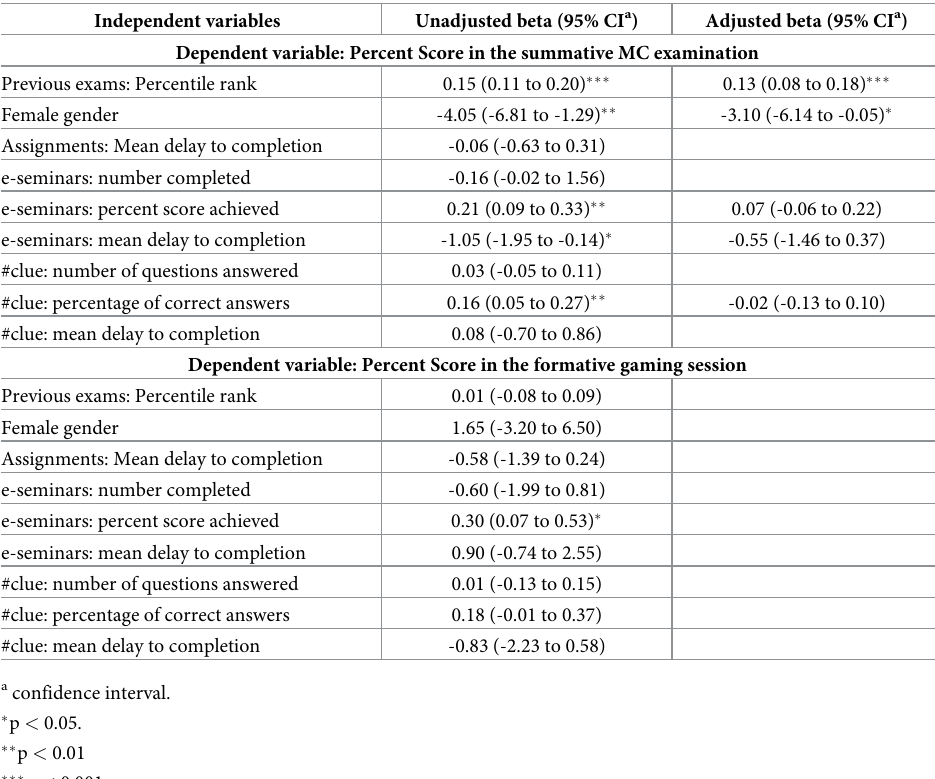
Table 1. Overall predictors of student performance. Independent